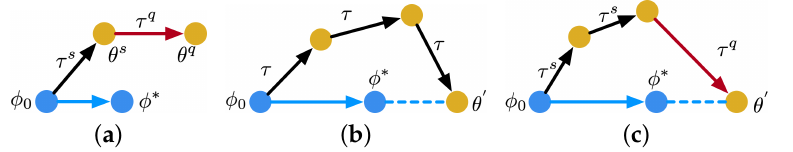
Figure 2. Optimization-based meta-learning algorithms. We use black and red arrows to represent the gradient steps in the inner loop and the outer loop, respectively. The blue arrow represents the direction of model update. ( a ) MAML; ( b ) Reptile; ( c ) our